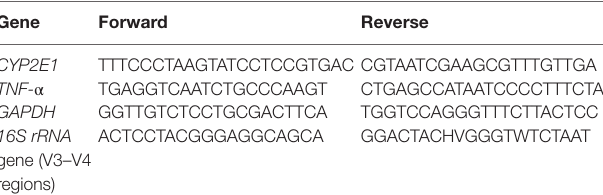
TaBle 1 | PCR primers used in this